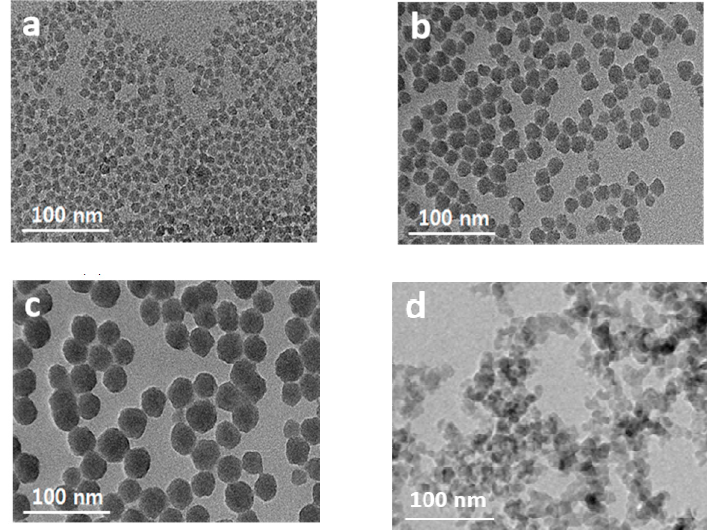
Figure 2. TEM images of differently sized silica particles. ( a ) 7 nm CSNPs; ( b ) 12 nm CSNPs;